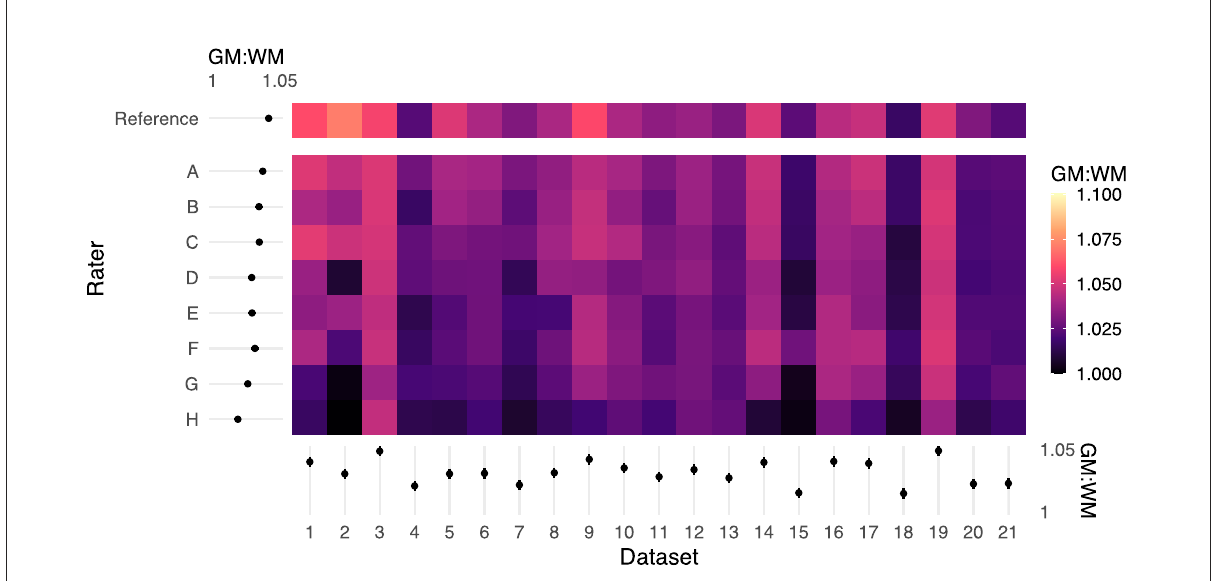
FIGURE4 Color map of GM:WM contrast across all rater registrations. Higher GM:WM contrast for a given input dataset indicates relatively better registration alignment. The margins (left and bottom) contain estimated marginal means for each rater and dataset, and error bars indicate 95% CIs. The reference masks produced registrations with the highest GM:WM contrast. Rater mask agreement with the reference mask (logit-transformed DSC) is correlated with higher levels of GM:WM contrast following spatial registration. Moreover, there are marked dataset effects on GM:WM, which are reflected by the ANOVA results.